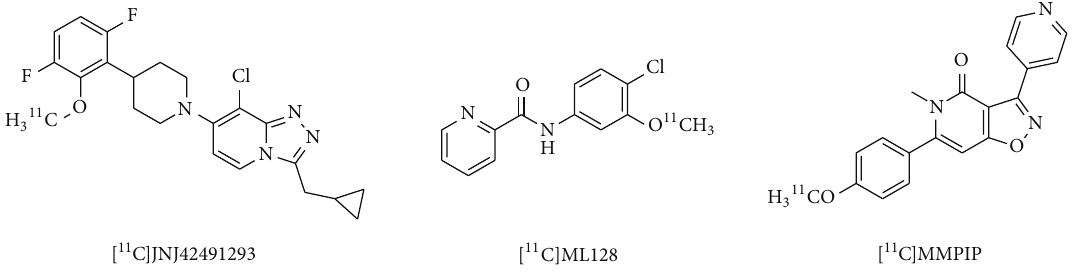
Figure 16: Chemical structure of imaging probes for groups II and III